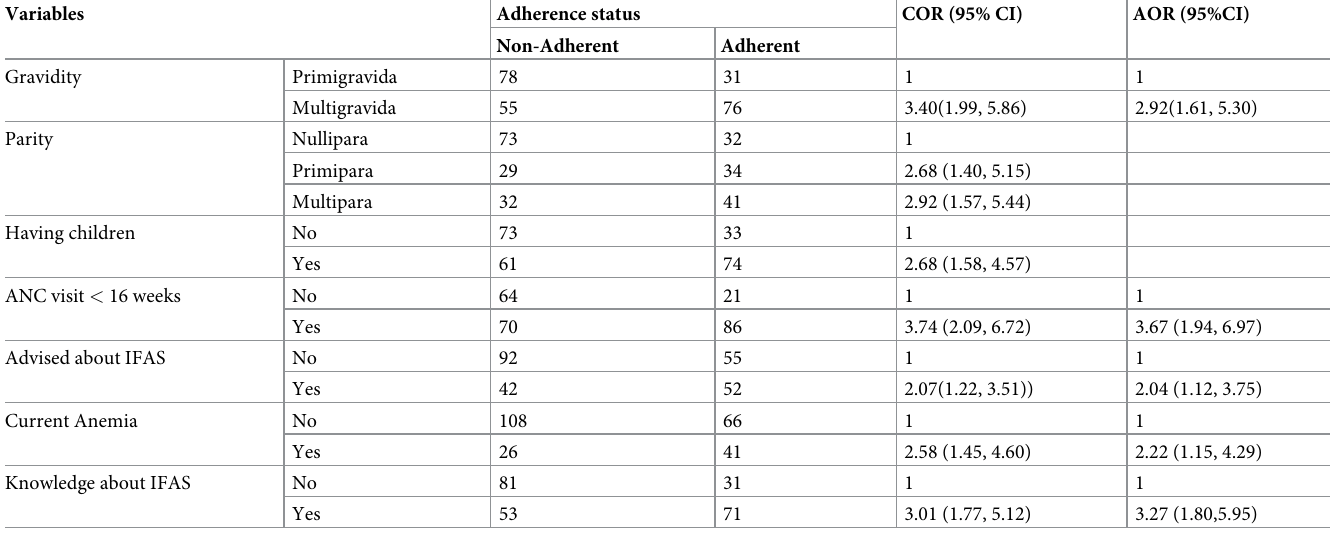
Table 3. Associated factors of IFAS among pregnant womena ANC service at Debre Tabor General Hospital, North West Ethiopia,